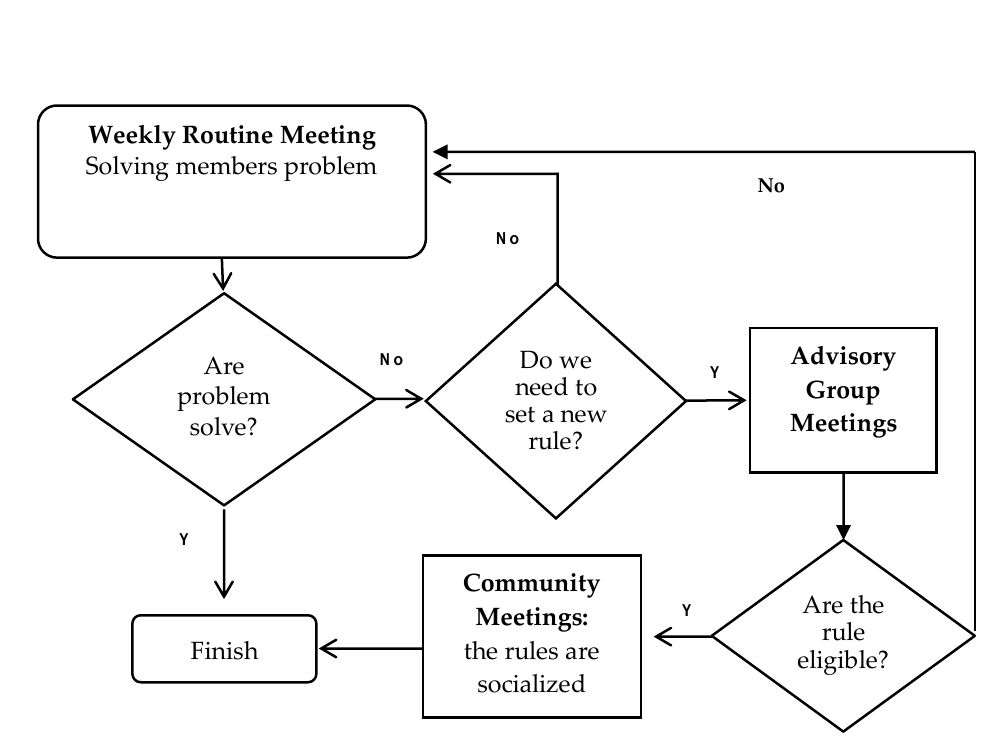
Figure 2. Just Community